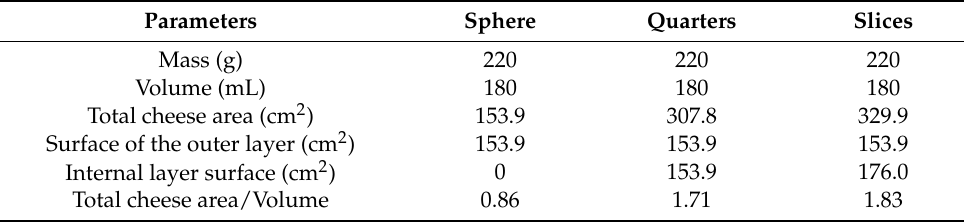
Table 1. Parametric data of fresh pasta filata cheese before and after portioning. Parameters